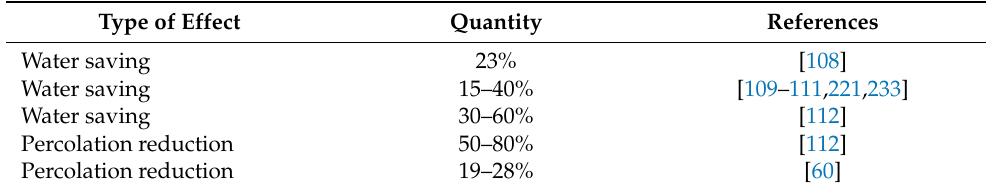
Table 3. Levels of water-saving by alternate wetting and drying (AWD) method compared to the continuous standing water rice